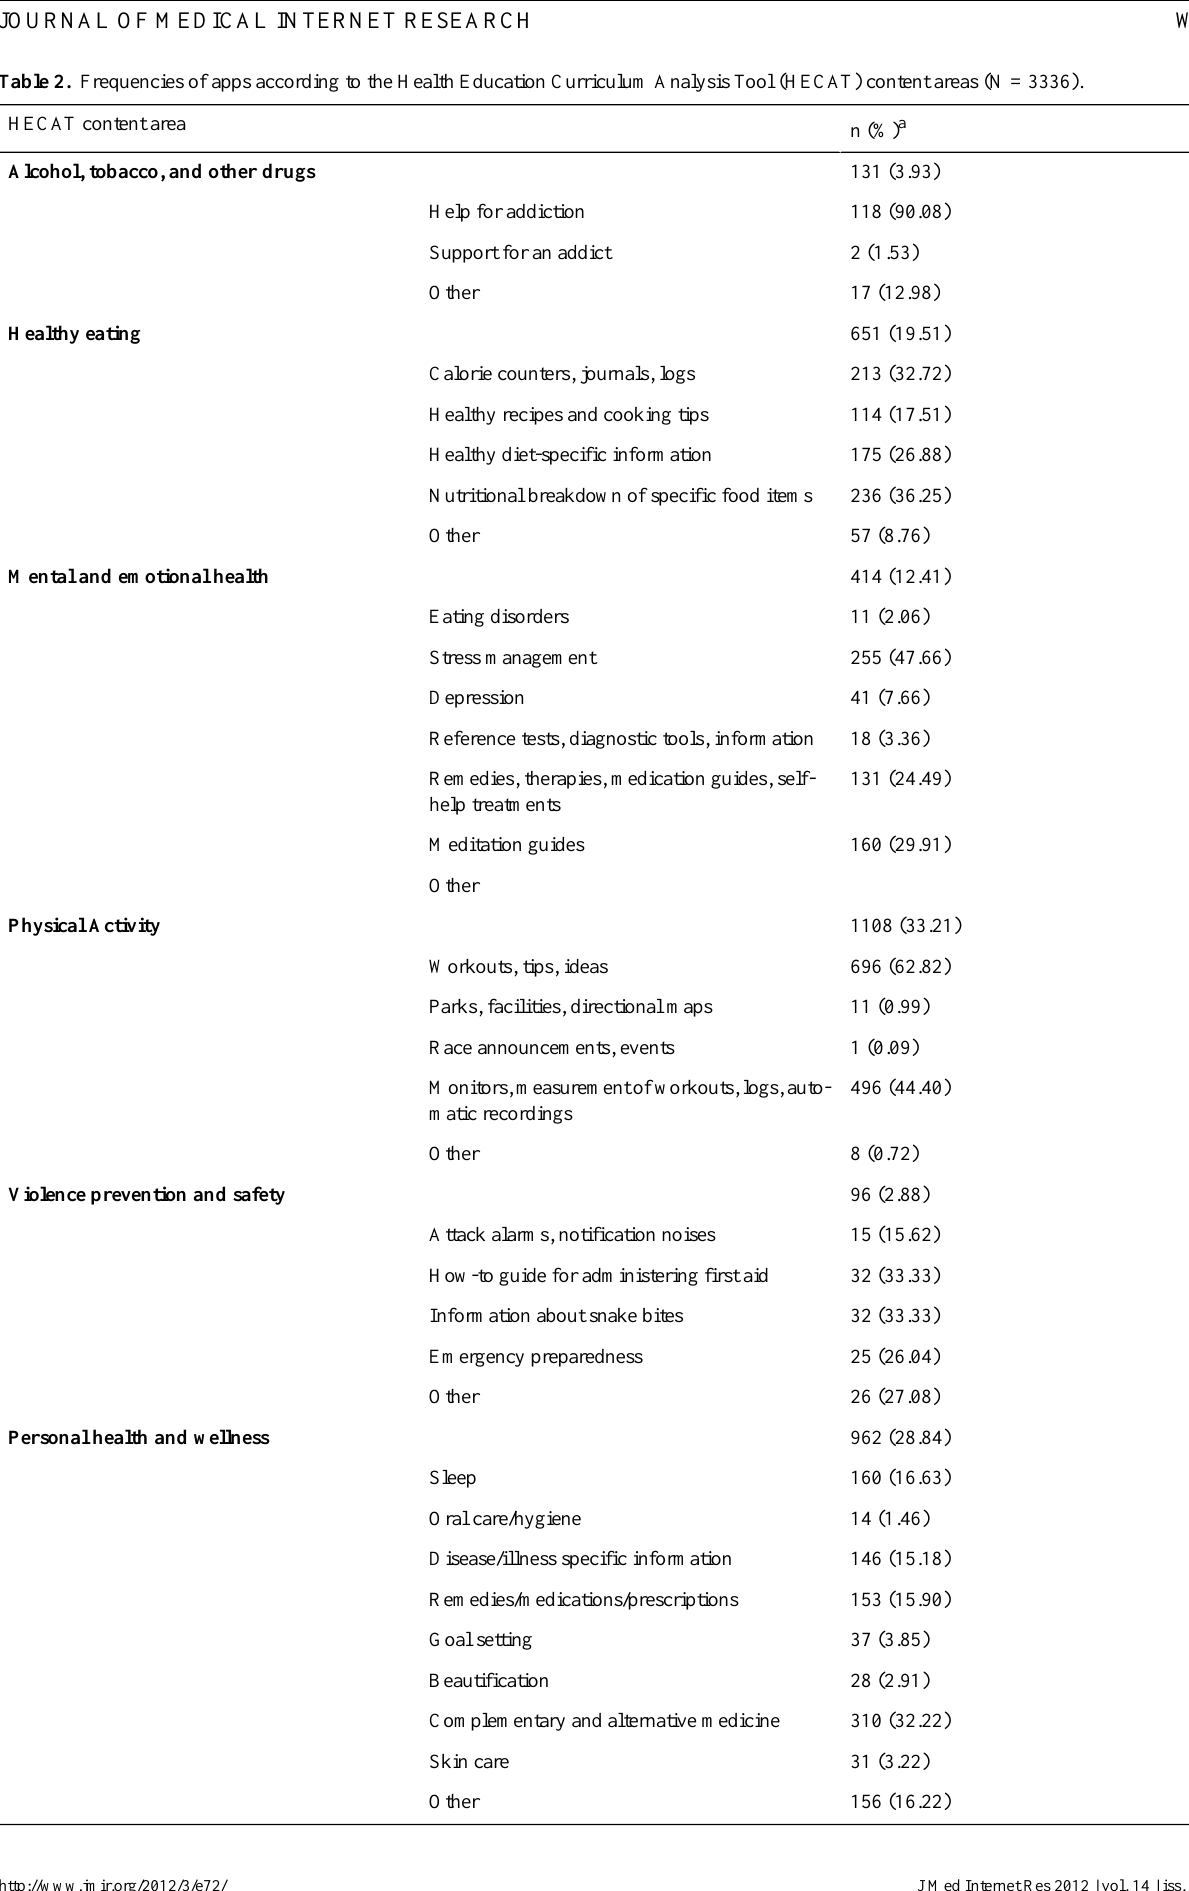
Table 2. Frequencies of apps according to the Health Education Curriculum Analysis Tool (HECAT) content areas (N =